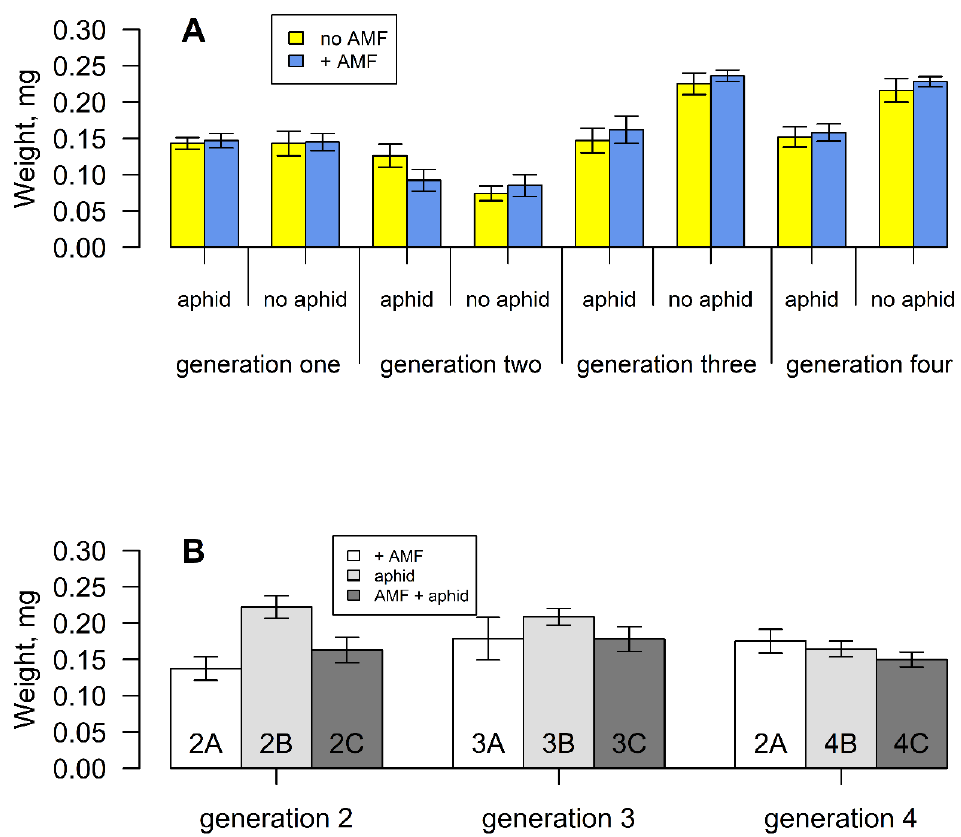
Figure 3. ( A ) Mean seed weight of S. vulgaris grown with or without arbuscular mycorrhizal fungi and aphids for four successive generations. Vertical lines represent ± one standard error. ( B ) Mean seed weight of S. vulgaris grown without AM fungi, aphids or both, from parents that experienced these treatments (2A, B and C; 3A, B and C and 4A, B and C plants in Figure